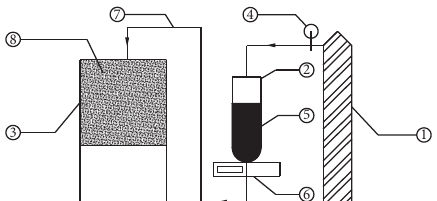
Figure 5: Schematic diagram of the operation principle of the grouting experiments. (1) Pressure supply device. (2) Grout storage container. (3) Experiment chamber. (4) Nitrogen pressure reducer and grouting control switch. (5) Newton fluid, grout of time-de- pendent behavior of rheological parameter. (6) Electronic scale. (7) Grouting pipe. (8) Gravel (sand) stone body with a uniform grain